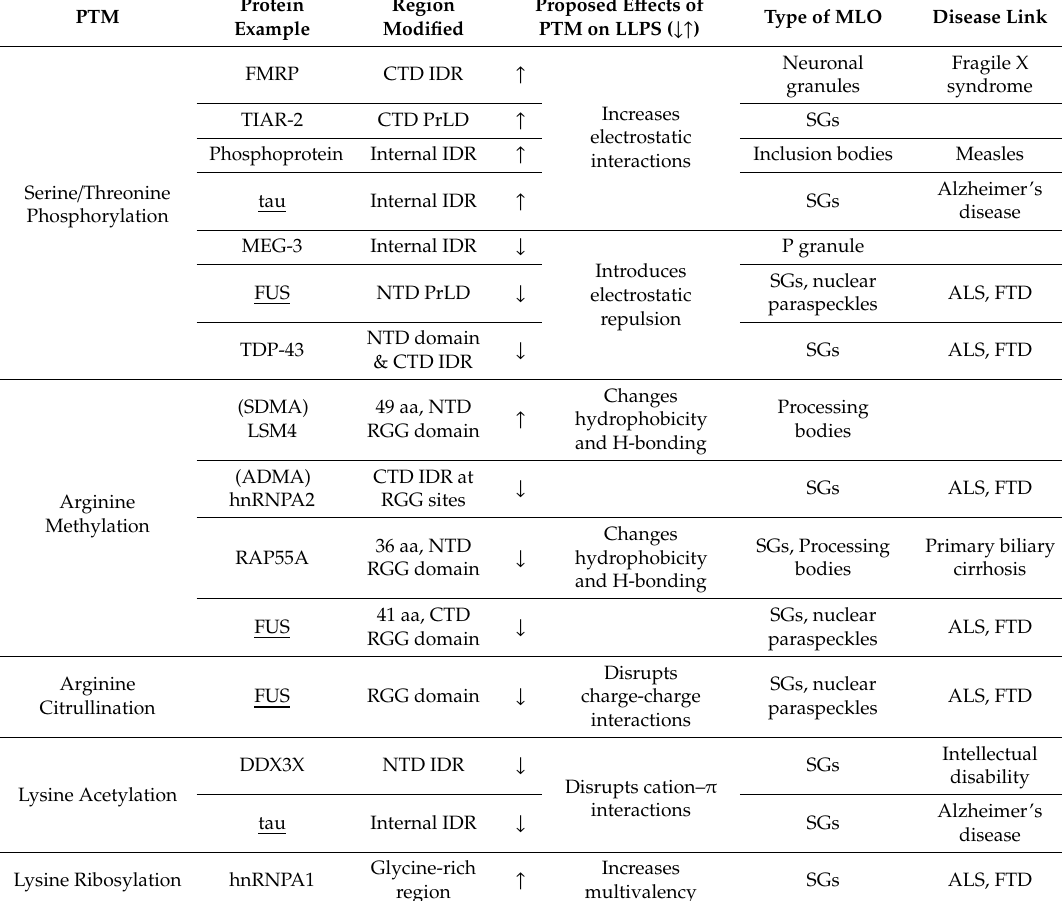
Table 1. Examples of post-translational modifications (PTMs) of intrinsically disordered regions (IDRs) altering the liquid–liquid phase separation (LLPS) of proteins. The underlined proteins have multiple PTMs that a ff ect the phase separation propensity. Arrows indicate if PTMs promote ( ↑ ) or inhibit ( ↓ ) LLPS. C-terminal domain (CTD), N-terminal domain (NTD), prion-like domain (PrLD), arginine-glycine-glycine (RGG), stress granules (SGs), amyotrophic lateral sclerosis (ALS), and frontal temporal dementia